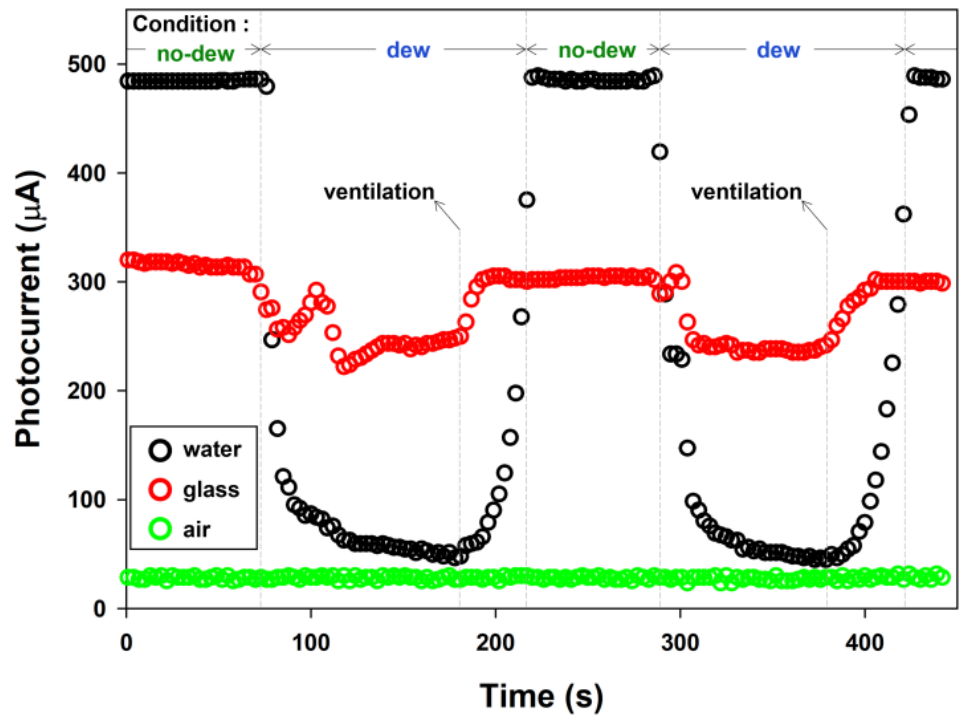
Figure 5. Responses of the actual sensors with the water-, glass-, and air-filled waveguides to dew condensation (the laser light wavelength: 650 nm).